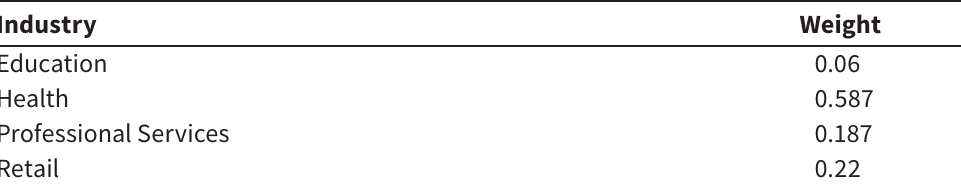
Weights for Constructing Synthetic Accommodation and Food Industry (Puerto Rican Industry